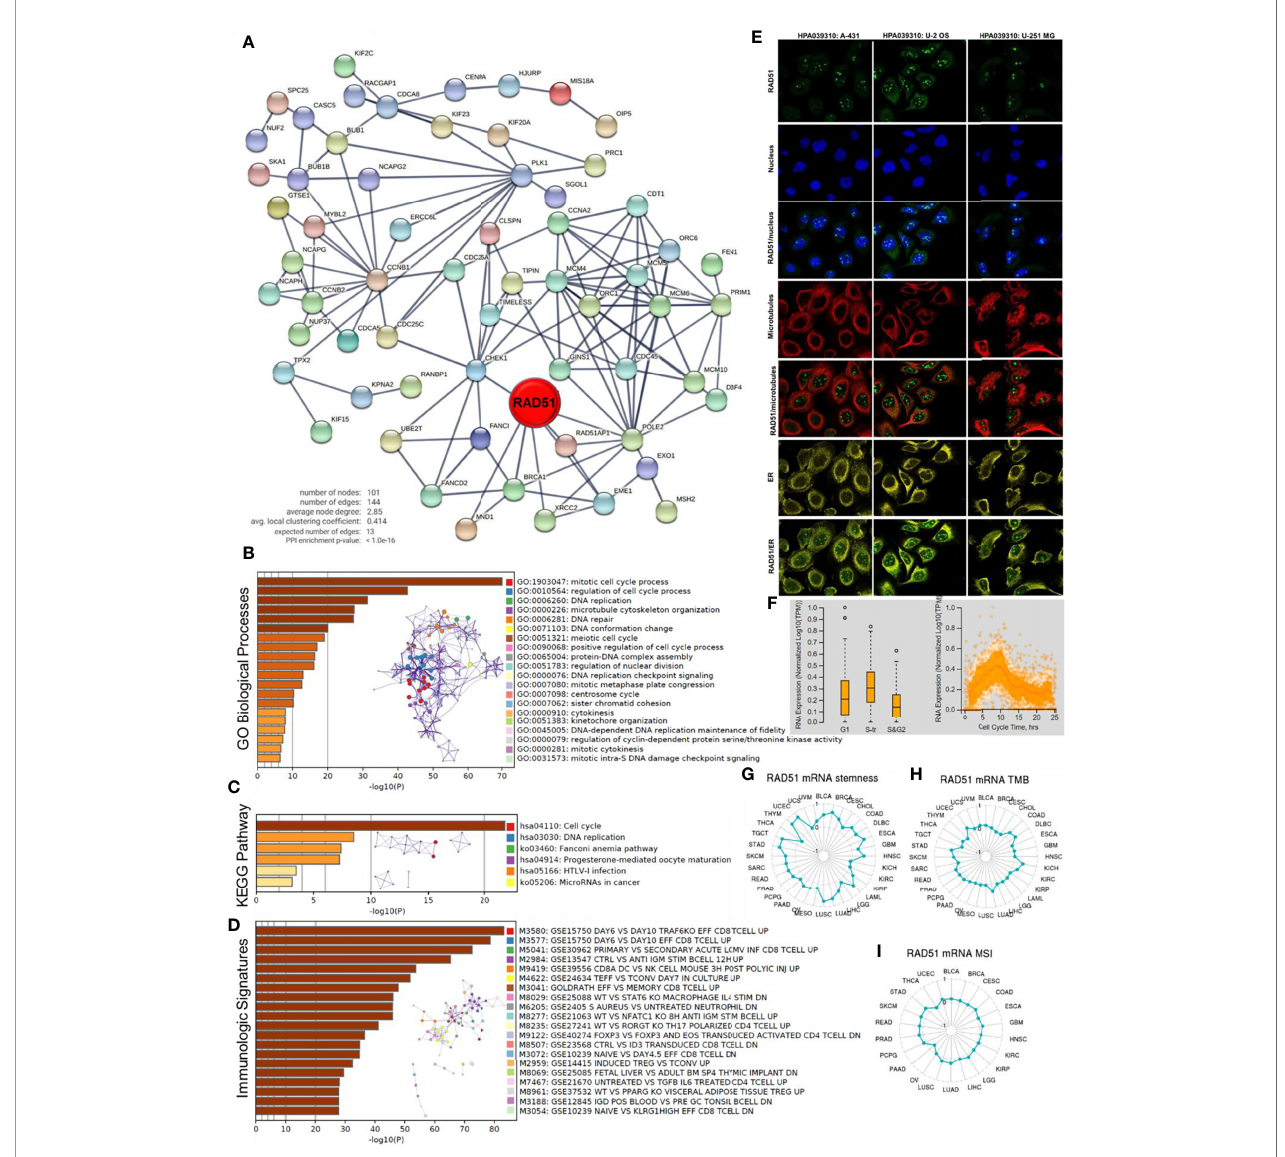
FIGURE 5 | Potential functions ofRAD51 in cancers. Top 100 RAD51 correlated genes were identi fi ed using theGEPIA based on all cancer andnormal tissue datasets compared in Figure 1A . (A) Protein-proteininteraction networkof top100 RAD51 correlatedgenes. (B) GO Biological Processes enrichment analysis of top 100 RAD51 correlatedgenes. (C) KEGG Pathwayenrichmentanalysis of top 100 RAD51 correlated genes. (D) Immunologic signatures enrichment analysis of top100 RAD51 correlated genes. All the enrichment analyses and enrichment network constructions were conducted using the Metascape. (E) Immuno fl uorescence staining of the subcellular distribution of RAD51 within the nucleus, endoplasmic reticulum (ER), and microtubules of A431 squamous carcinoma cells, U-2 OS osteosarcoma cells, and GBM cells. (F) Plots ofsingle- cell RNA-sequencing datafrom the FUCCI U-2 OS osteosarcoma cellline, showing the correlation betweenRAD51 mRNA expression andcellcycleprogression. (G) The correlationof OCLR scores andRAD51 in TCGA cancer data. OCLR algorithm was used to calculate the mRNAsi (OCLR scores) for the evaluationofstemness. (H) The correlationof tumor mutational burden (TMB) andRAD51 inTCGA cancer data. (I) The correlationof microsatellite instability(MSI) andRAD51 in TCGA cancer